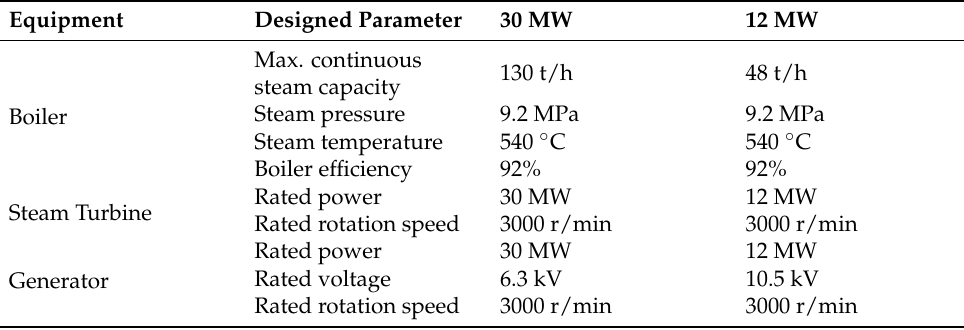
Table 1. Specifications of the equipment used in the selected